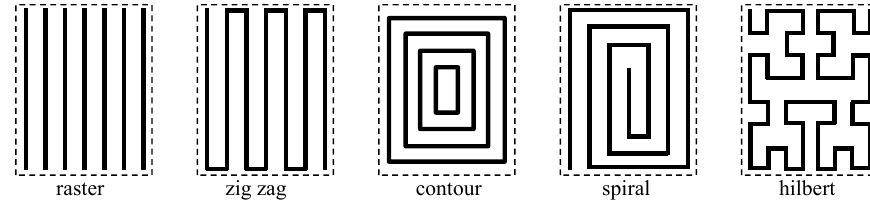
Figure 4. Common infill strategies in